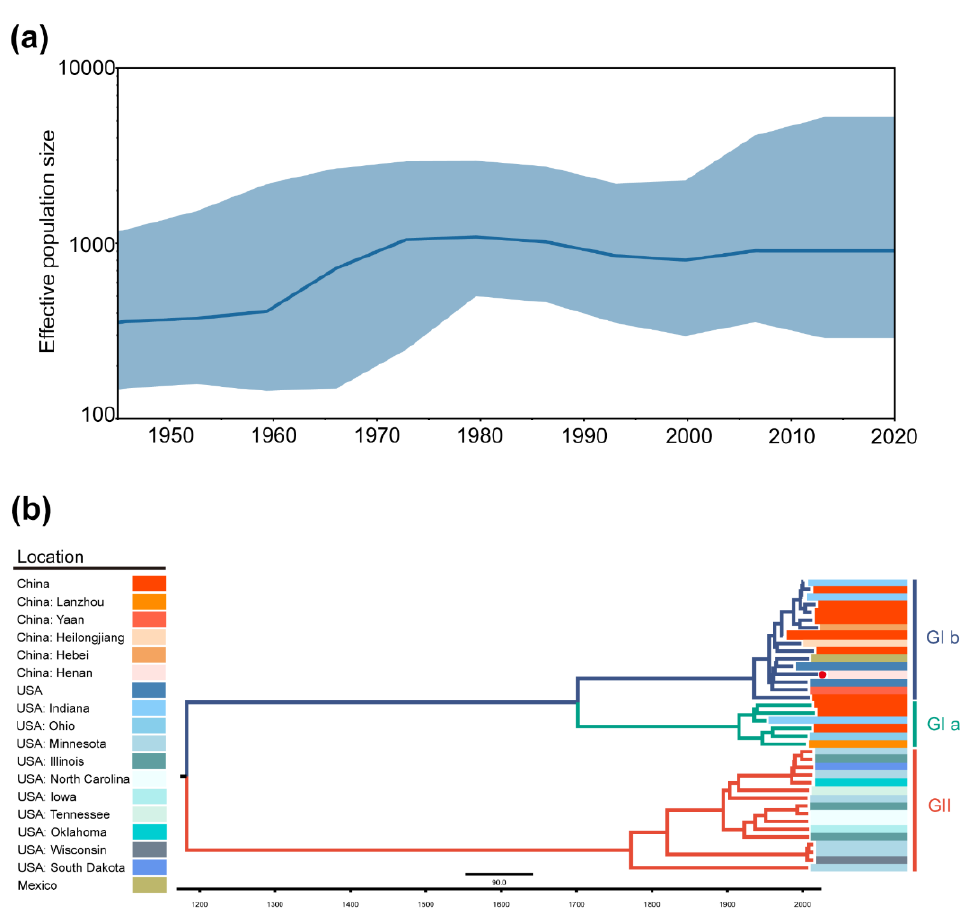
Figure 4. Demographic history of TGEV. ( a ). Demographic history was inferred via Bayesian skyline analysis. The median and 95% HPD intervals were plotted. ( b ). MCC tree of TGEV complete genome. Different colors represented different genotypes. The red dot indicates that the strain was sequenced in this study.